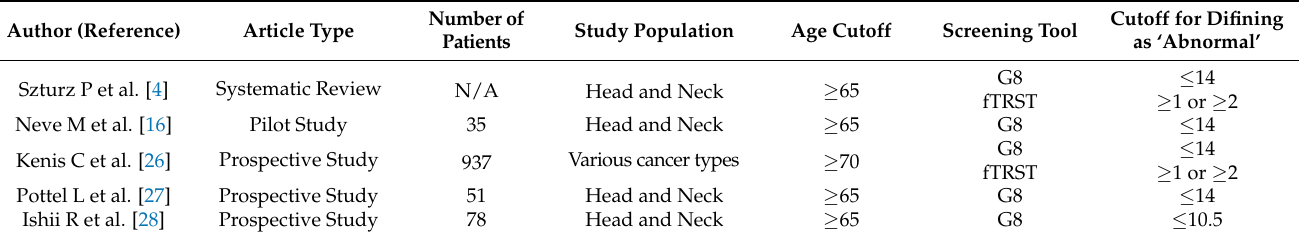
Table 1. Studies for geriatric assessment